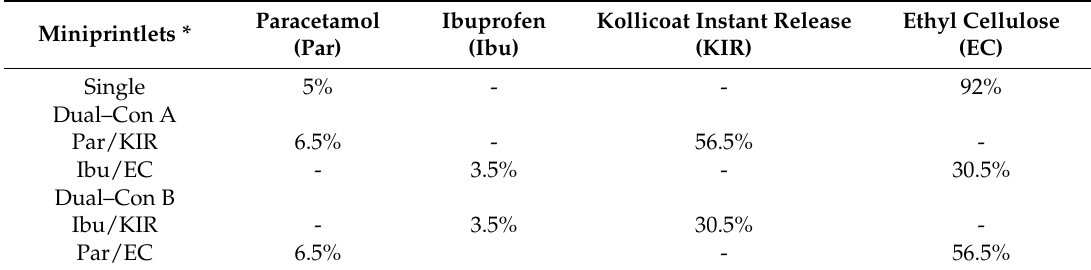
Table 1. Compositions of the single and dual miniprintlets.